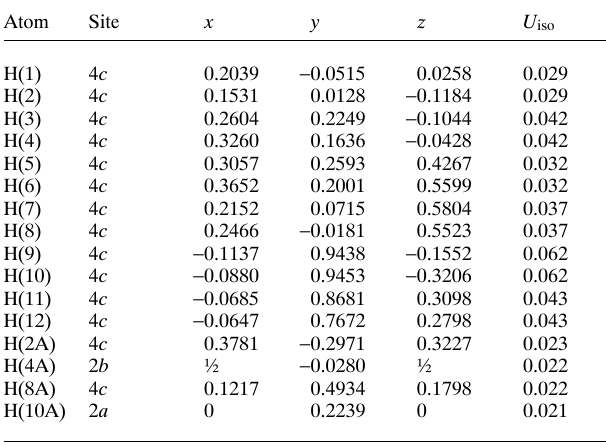
Table 2. A tomic coordin a tes a nd displ a cement p a r a meters (in Å 2 )